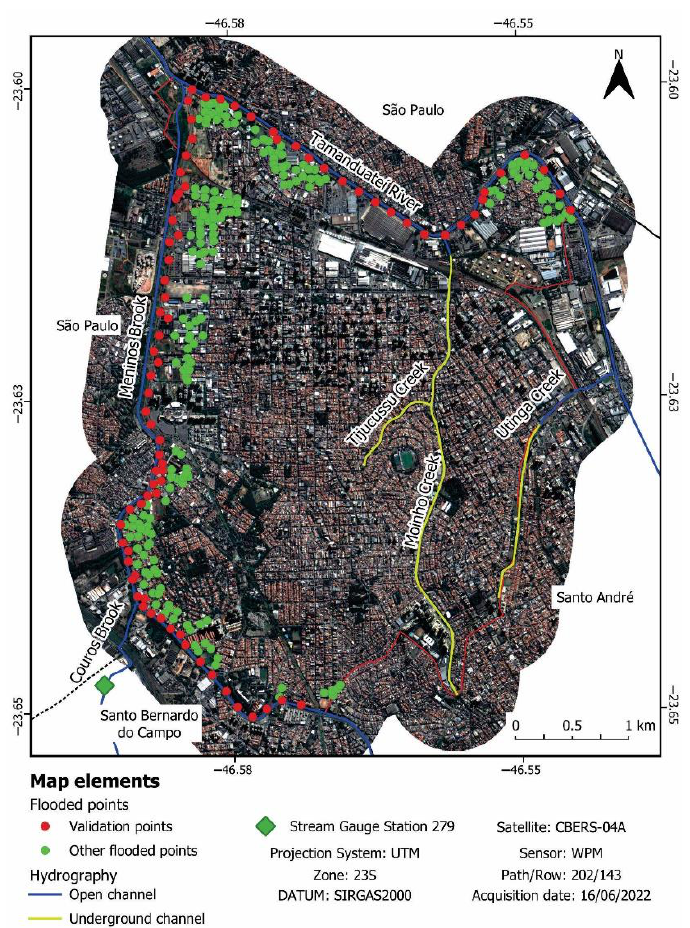
Figure 3. CBERS-04A satellite image of São Caetano do Sul and its municipal limits (red line) surrounded by a 500 m buffer, indicating flooded points reported by the civil defense of São Caetano do Sul and its citizens on March 10 of 2019 (a 79-year return period event). Red points are used for validation since they are reported with estimated water depth.